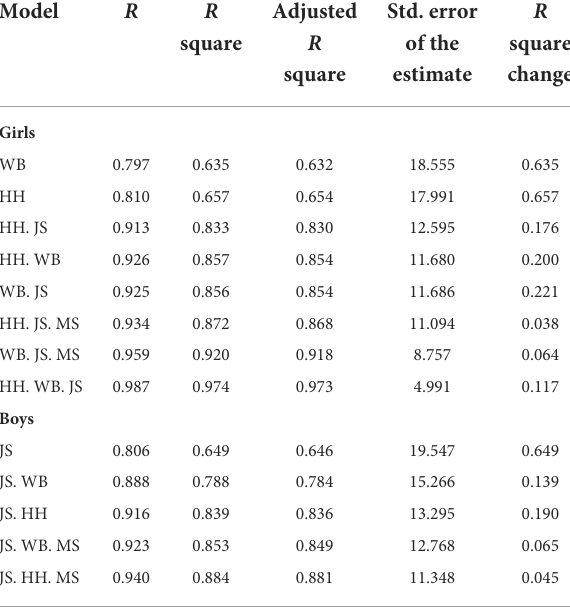
TABLE 2 Data from stepwise linear regression declared among 6-year aged subject of both sexes.